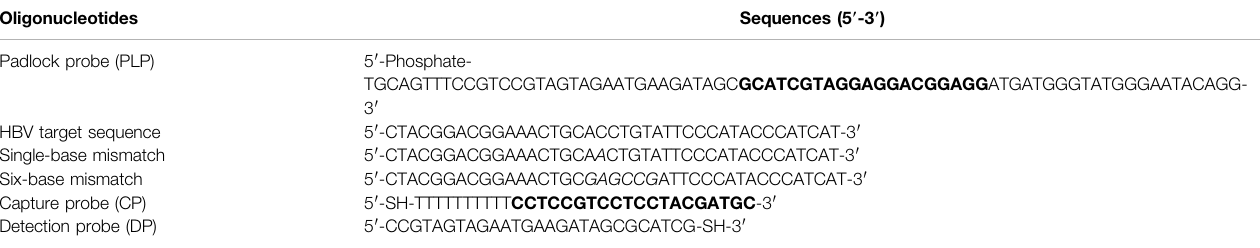
TABLE 1 | Sequences of oligonucleotides used in the study.